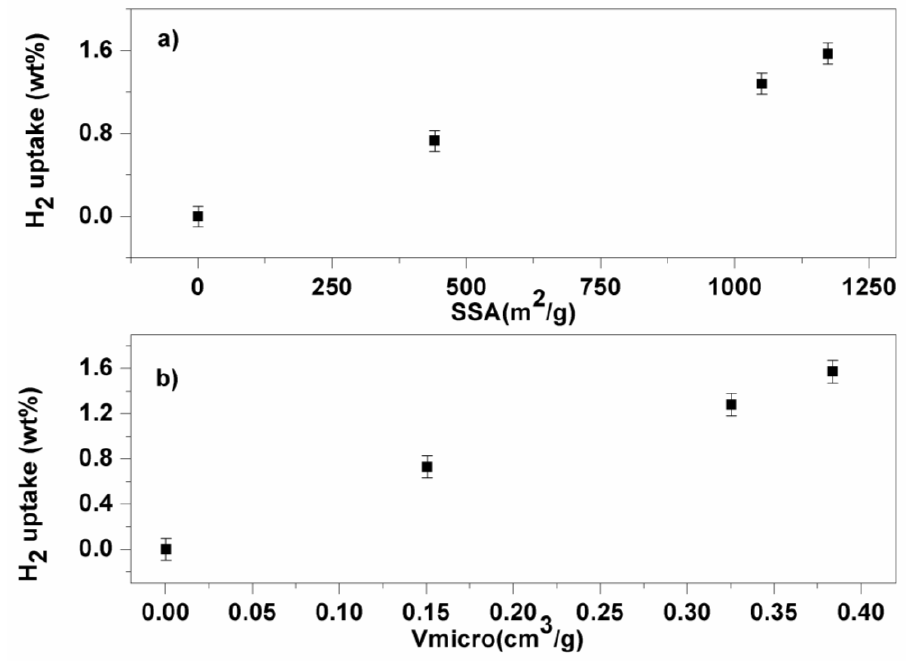
Figure 8. ( a ) H 2 uptake at 1 bar and 77 K vs. SSA. ( b ) H 2 uptake at 1 bar and 77 K vs. V micro .